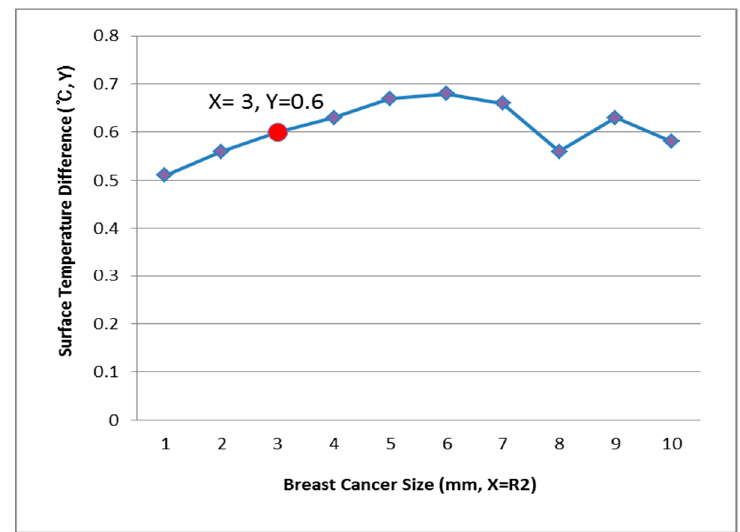
Figure 14. Surface temperature difference for an R1 of 80 mm (X = 10, Y = 10).